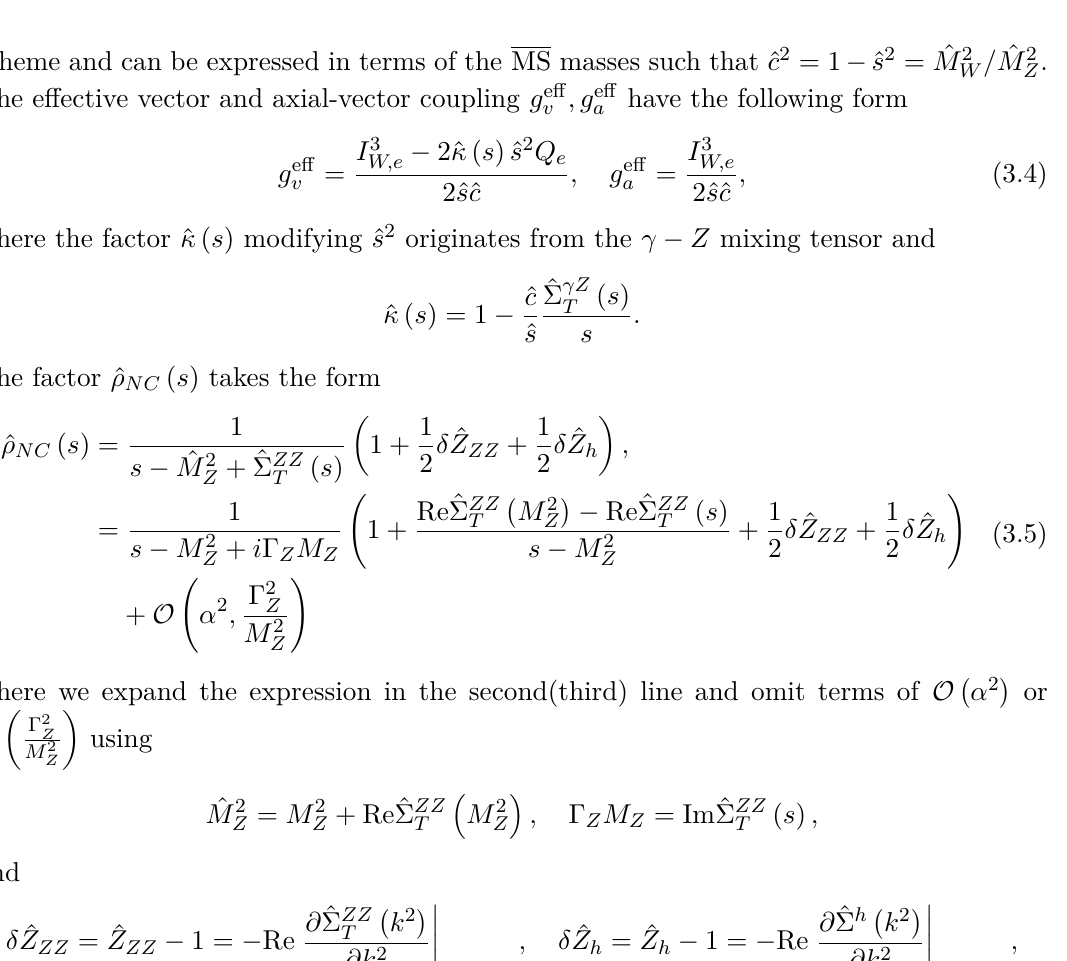
Figure 2. General one loop contributions to e + e − → Zh amplitude. The blobs denote one loop irreducible diagrams, and these hatched indicate where the extended scalar loop corrections can take